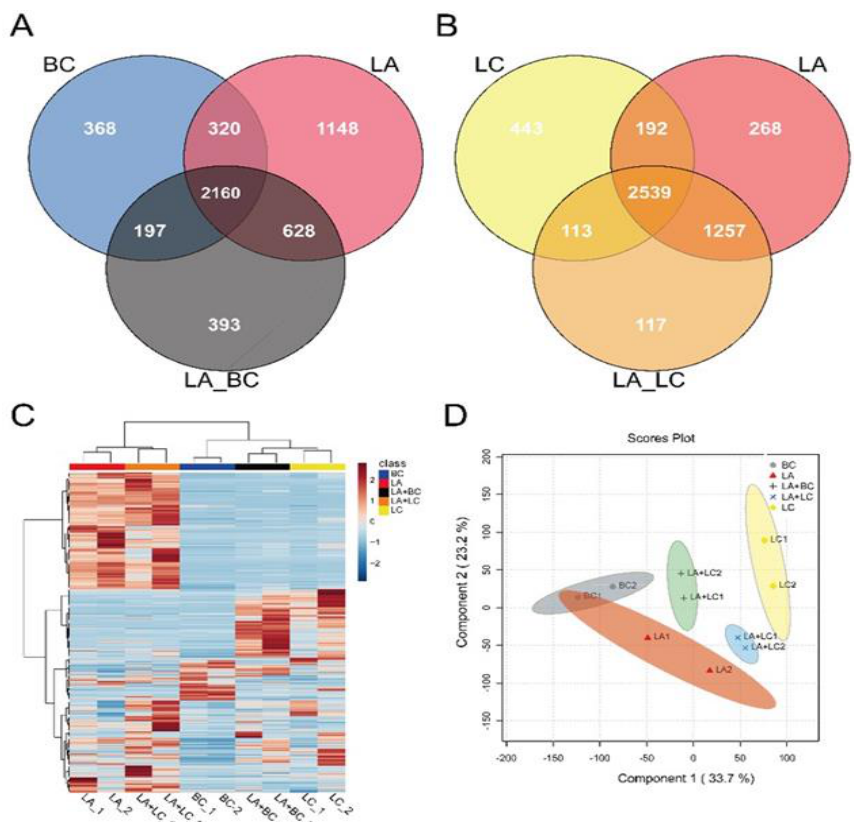
Figure 3. Metabolomics outline for the number of differently expressed metabolites of BCAs as single strain and co-culture. Inter-genus bacterial co-culture ( A ), intra-genus bacterial co-culture ( B ), unsupervised hierarchical cluster analysis carried out from untargeted metabolomics profiles of BCAs ( C ), principal component analysis ( D